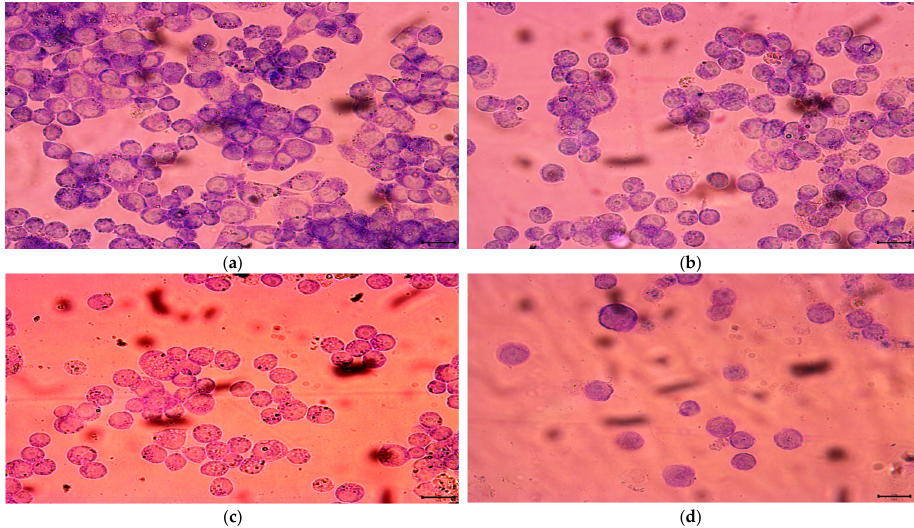
Figure 6. Wright-Giemsa staining assay detected the effect of rAj-Tspin on the morphology of LLC cells. The bar indicates 10 μ m; ( a ) control; ( b ) 1.85 μ M rAj-Tspin; ( c ) 2.20 μ M rAj-Tspin; ( d ) 3.04 μ M rAj-Tspin. Molecules 2021 , 26 , x FOR PEER REVIEW